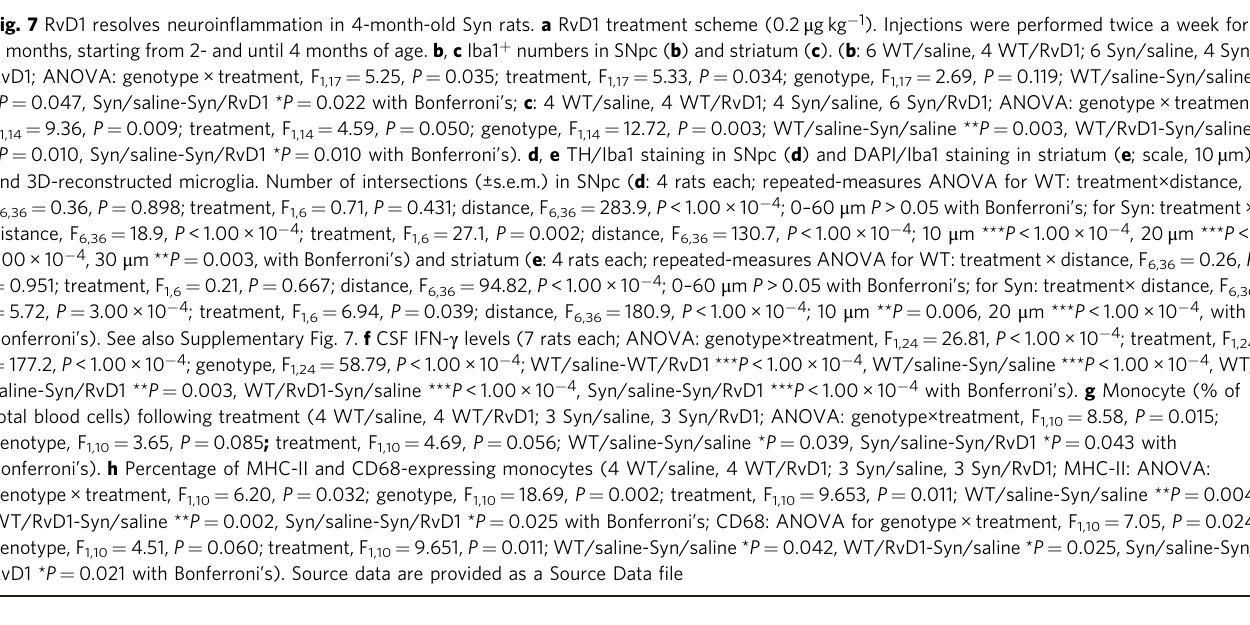
Fig. 7 RvD1 resolves neuroin fl ammation in 4-month-old Syn rats. a RvD1 treatment scheme (0.2 μ g kg − 1 ). Injections were performed twice a week for 2 months, starting from 2- and until 4 months of age. b , c Iba1 + numbers in SNpc ( b ) and striatum ( c ). ( b : 6 WT/saline, 4 WT/RvD1; 6 Syn/saline, 4 Syn/ RvD1; ANOVA: genotype × treatment, F 1,17 = 5.25, P = 0.035; treatment, F 1,17 = 5.33, P = 0.034; genotype, F 1,17 = 2.69, P = 0.119; WT/saline-Syn/saline * P = 0.047, Syn/saline-Syn/RvD1 * P = 0.022 with Bonferroni ’ s; c : 4 WT/saline, 4 WT/RvD1; 4 Syn/saline, 6 Syn/RvD1; ANOVA: genotype ×